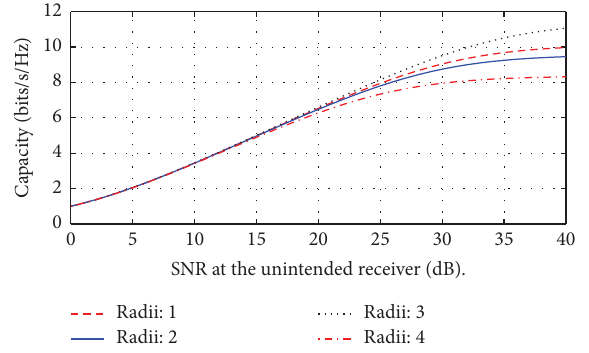
Figure 24: Capacity comparison: unintended receiver at (110 degrees azimuth, 35 degrees elevation). Te radius values are wavelength